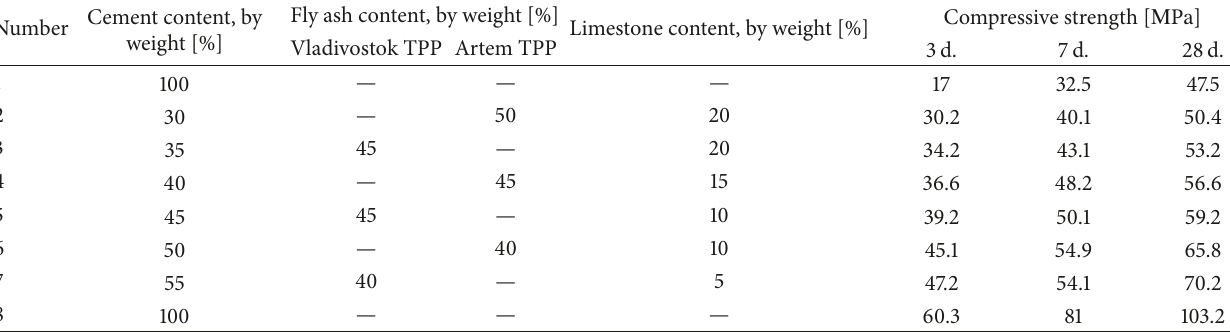
Table 5: Compositions and strength of composite binders.